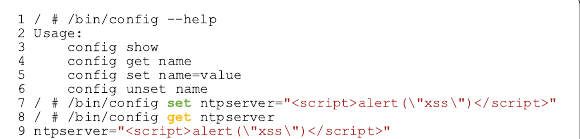
mutation of the value of a k-v pair. As a result, after pars- ing k-v pairs from the raw requests and labeling them, the seeds can be generated more effectively.